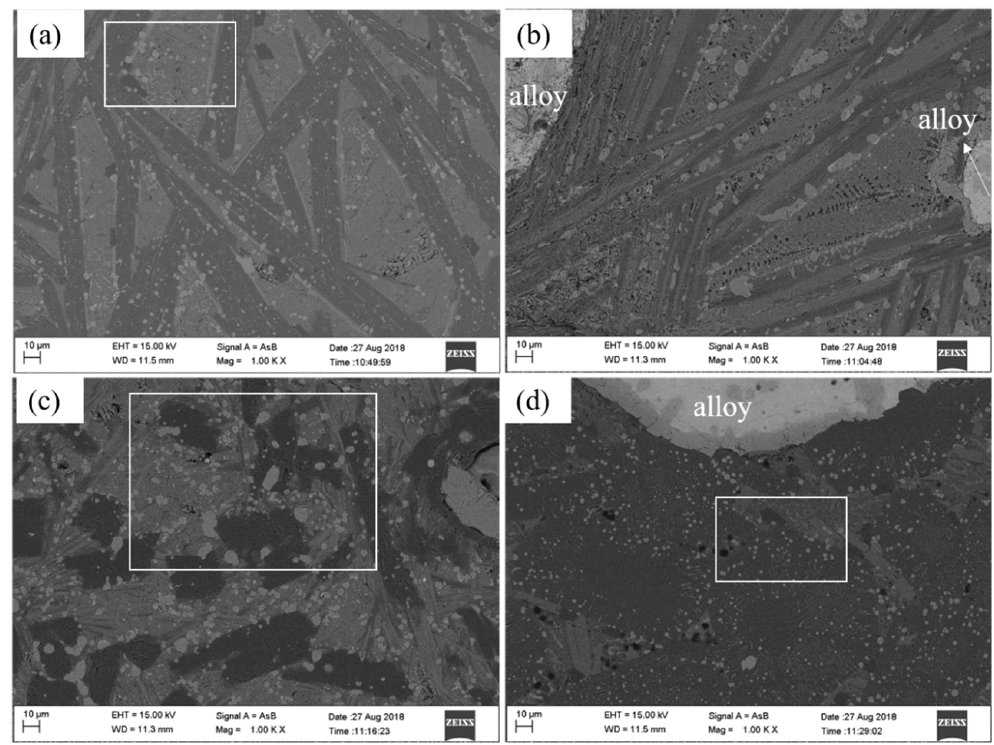
Figure 5. Microstructures of slag produced from ilmenites with different reduction degrees. ( a ) 0%, ( b ) 11%, ( c ) 43%, and ( d ) 75%.